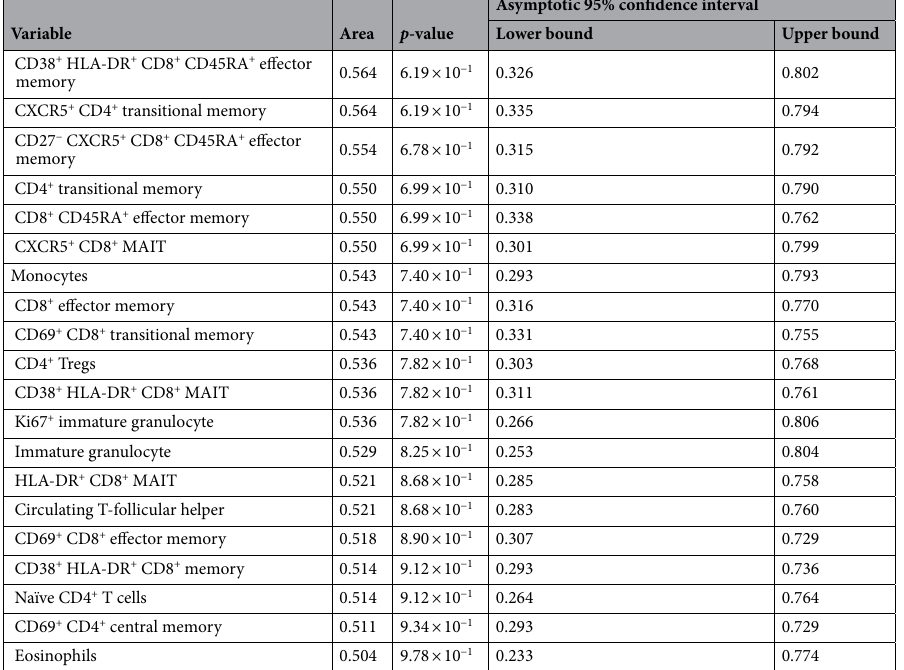
Table 5. Estimating the predictive ability of various analytes in identifying severe COVID-19 patients in a patient population with either moderate or severe disease using the area under a receiver operating characteristic curve (AUC) method. BLR binary logistic regression probabilities. Shown p -values are corrected for multiple testing using Holm method. Cell populations are expressed as percentages of their respective parent populations except for where mean fluorescence intensity (MFI) is